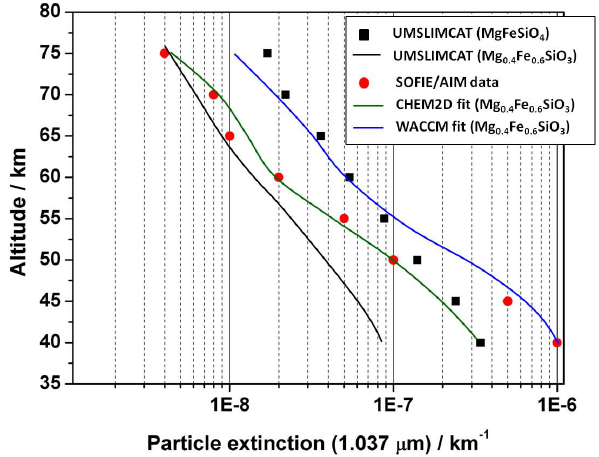
Fig. 6. Comparison of measured MSP extinction (labelled SOFIE/AIM) with values calculated using MSP number concen- trations from the UMSLIMCAT model and Rayleigh theory for an assumed olivine (MgFeSiO 4 ) composition, and for the same pyrox- ene species (Mg 0 . 4 Fe 0 . 6 SiO 3 ) used to fit the SOFIE data in Hervig et al. (2009). Also shown are the predicted MSP extinction profiles from the WACCM and CHEM2D models, reproduced from Figure 2 in Hervig et al.